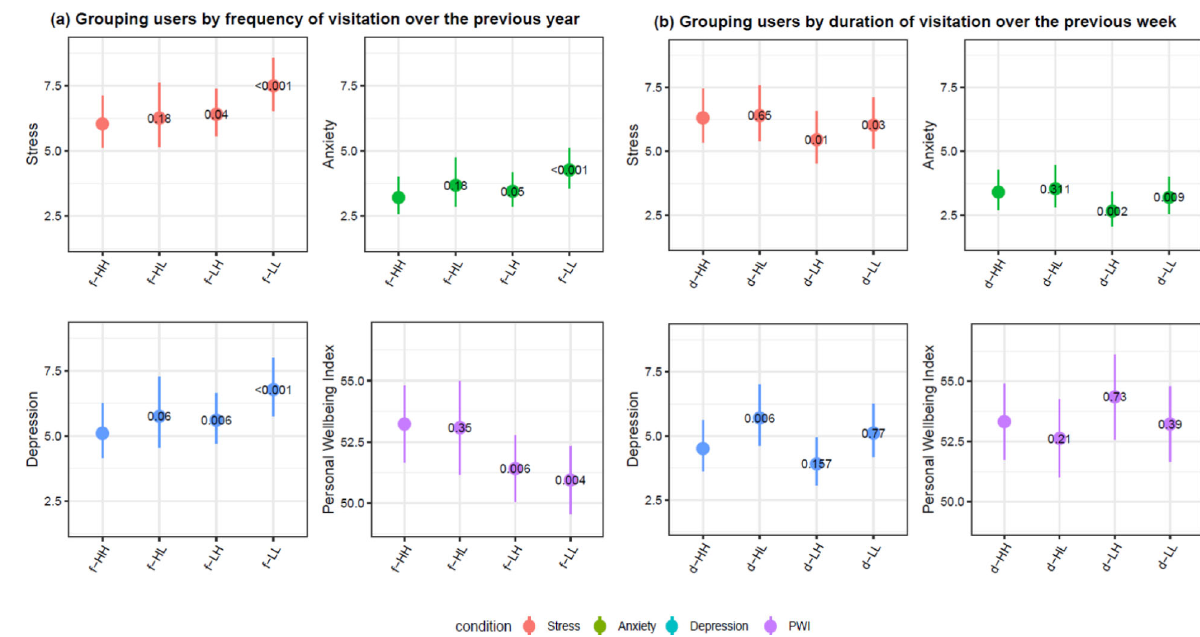
Fig. 2 Examining differences in the four strati fi ed end user types. The two panels represent differences across end user types based on frequency over the year (f-xx, panel a ) and duration over the last week (d-xx, panel b ) measures. The fi rst x position represents yard use and the second x position represents public green space use (HH – high yard/high GS; HL – high yard/low GS; LH – low yard/high GS; LL – low yard/low GS; GS = public green space). Self-reported stress (orange), anxiety (green), depression (teal), and wellbeing scores (purple) are presented across the two different measure of use, frequency of use over the past year and duration of use in the week prior to the survey. The y -axis represents the average score for stress, anxiety, depression, and PWI (Personal Wellbeing Index), and fi gures include the estimate and 95% con fi dence intervals of the relationship between different combination of green space visits are presented after controlling for demographic